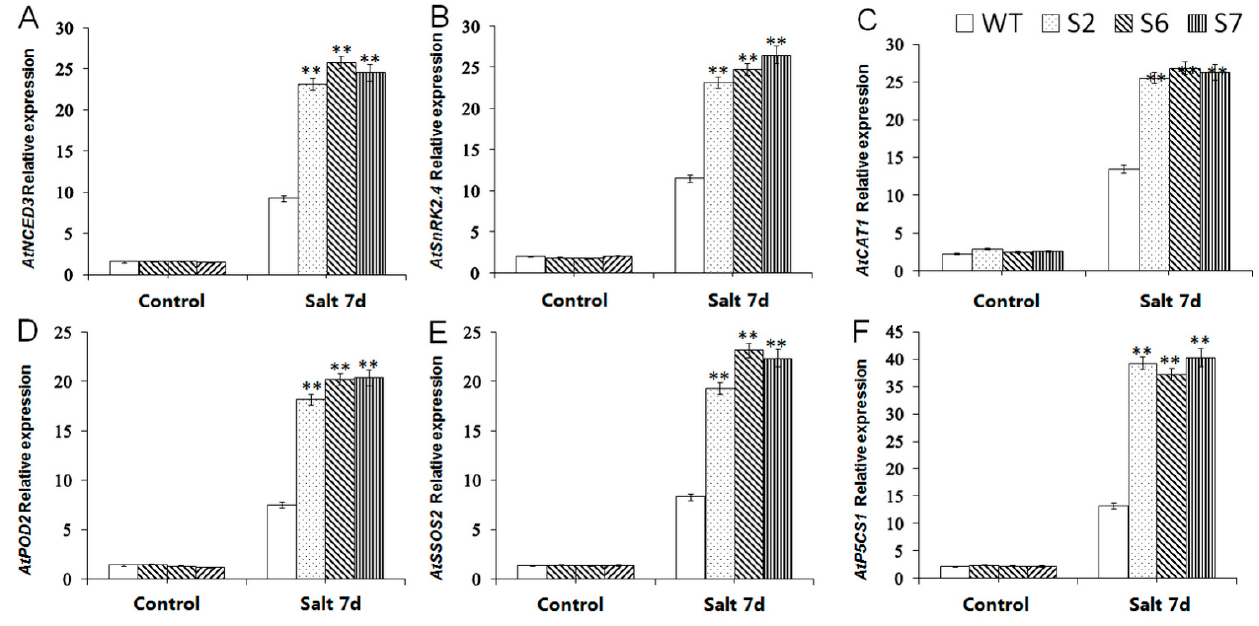
Figure 9. Expression levels of 6 salt stress related genes—( A ) NCED3 , ( B ) SnRK2.4 , ( C ) CAT2 , ( D ) SOD1 , ( E ) SOS2 , and ( F ) P5CS1 in WT and transgenic Arabidopsis under salt stress. The standard error was the average of 3 repeated tests. The asterisk above the column indicated that there was a significant difference between the transgenic lines and the WT lines under salt stress (** p ≤ 0.01).